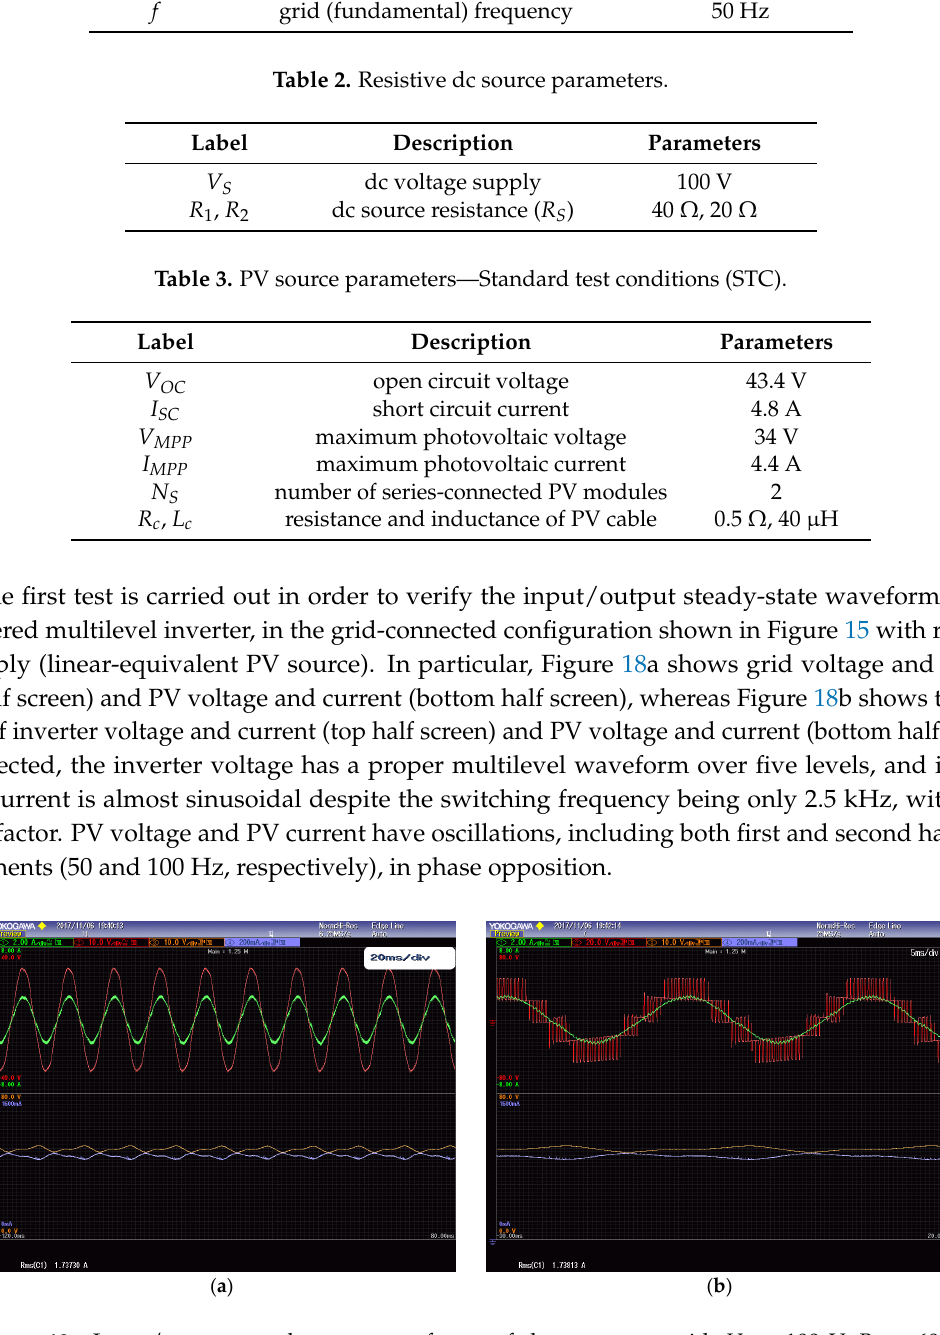
Table 1. Parameters of the conversion system.